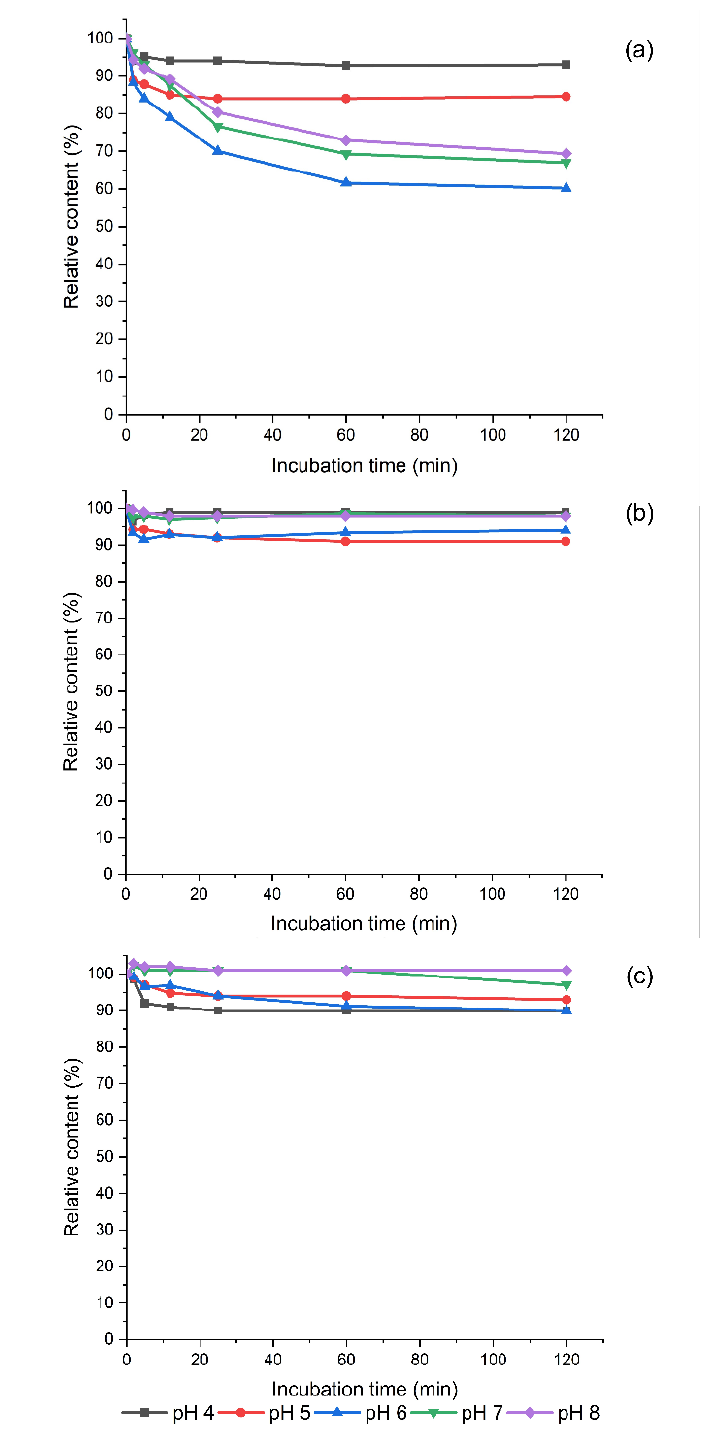
Figure A2. Time-dependent degradation of ( a ) tryptamine (TRP), ( b ) phenethylamine (PHE), and ( c ) histamine (HIS) by homogenized fenugreek sprouts at different pH values.